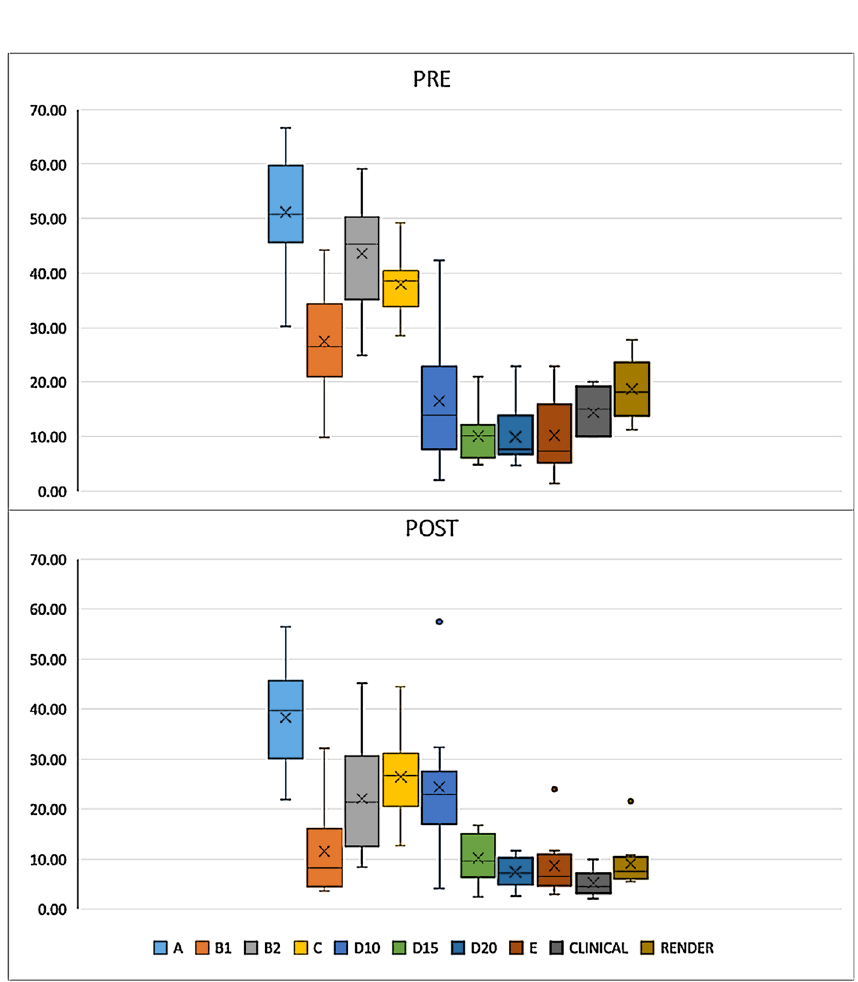
Figure 3. Boxplot with relevant outliers; the HAA measurements from all techniques for pre-op (top) and post-op (bottom). Outliers were not found in the pre-op